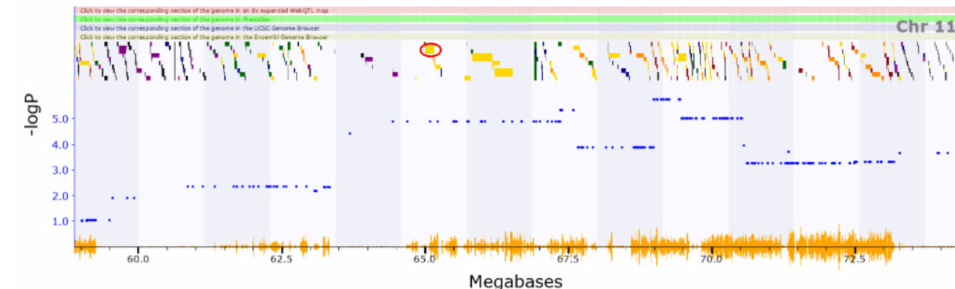
Figure 5. A QTL for motor activity in response to cocaine revealed five genes with cis-eQTLs. Arhgap44 shown in the red circle (65.01 Mb) associates with abnormal motor learning, abnormal response to novel objects, increased grooming behavior, and hypoactivity.